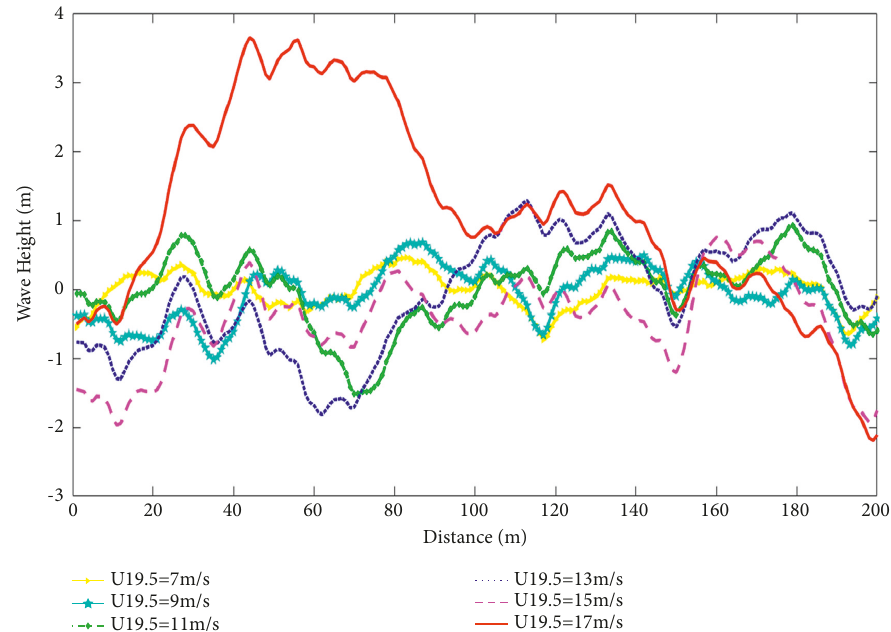
Figure 2: The random instantaneous ocean wave cross-sections generated under different wind speeds.